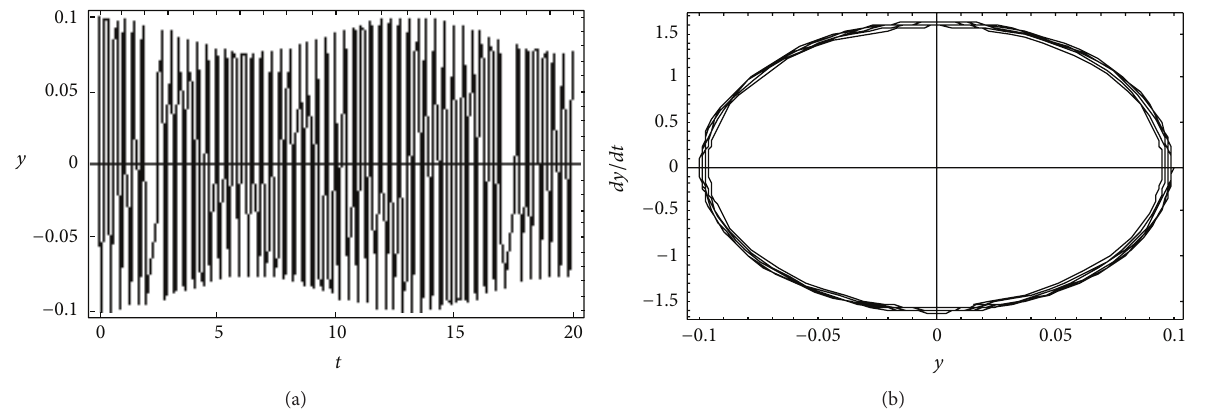
Figure 5: Time domain curve and phase plane about the systems 𝜎 = 0 , 𝛾 = 𝜋/6